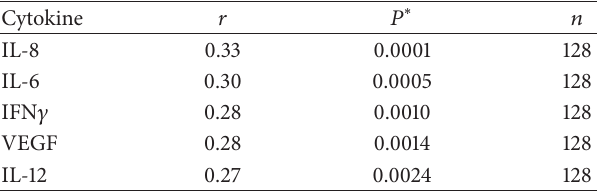
Table 3: Correlations of MMP-3 with cytokines. Table 4: Correlations of SAA and CRP with clinical and laboratory indices of disease